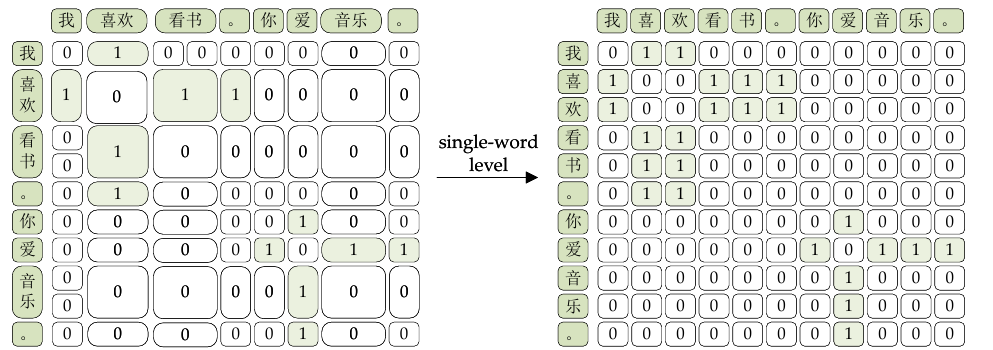
Figure 6. Dependency syntax matrix. The figure shows the rules for the construction of the DP matrix: the coordinates corresponding to the two words for which there is a dependency are set to one.